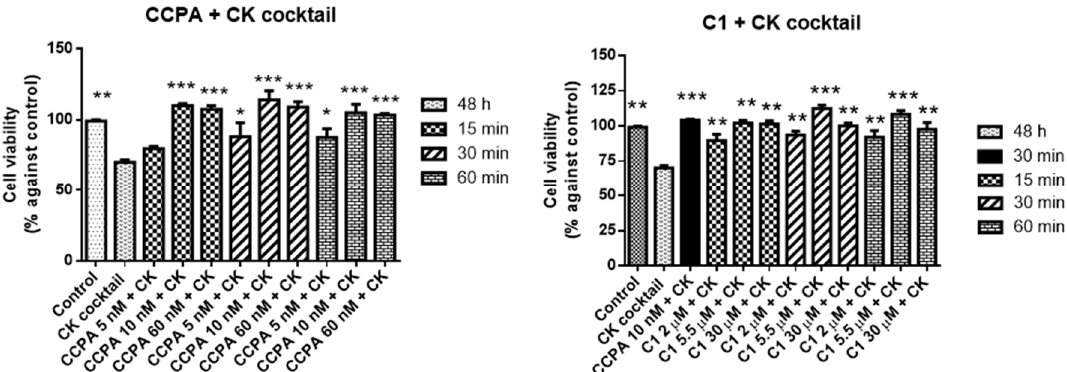
Figure 5. Protective e ff ects of CCPA and C 1 against CK aggression on mixed glial cell culture. Percentage of cell viability after treatment with the CK cocktail for 48 h. Results represent the average of 3–5 independent experiments. * p < 0.05, ** p < 0.01, *** p < 0.001 of treated cells against CK.